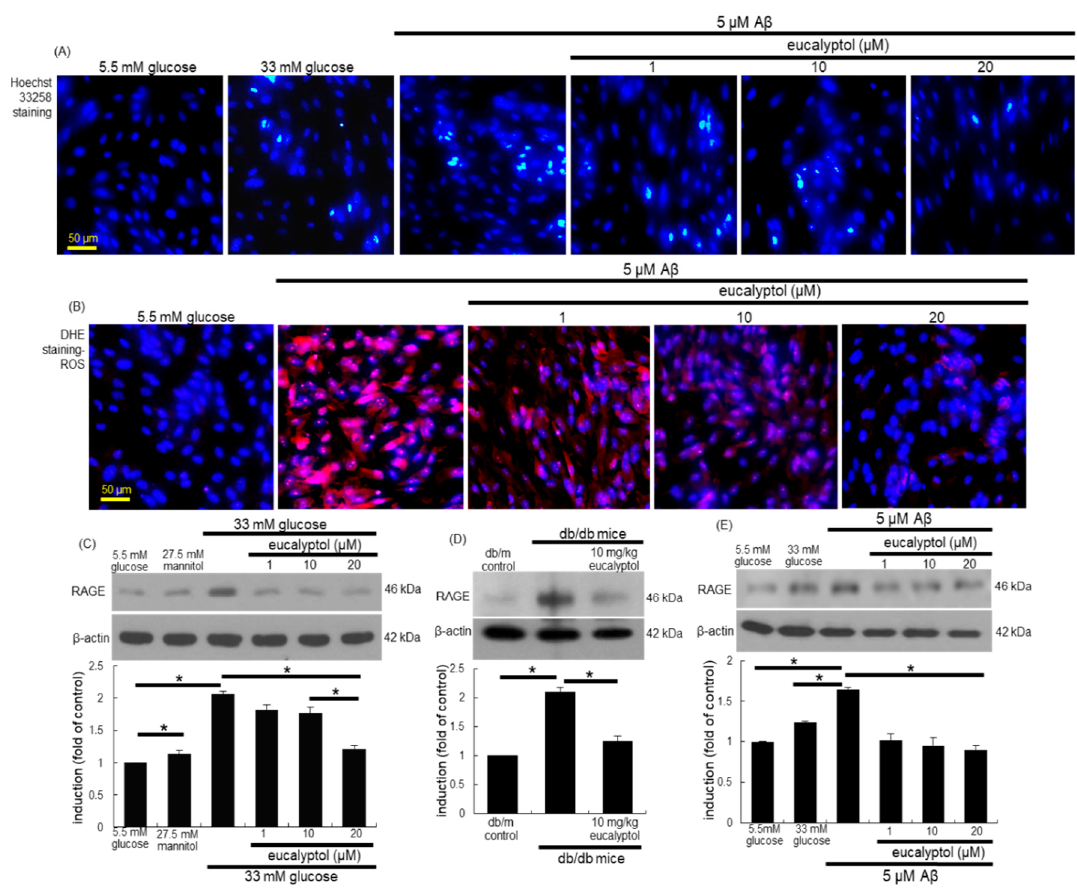
Figure 9. Blockade of A β -induced nuclear condensation ( A ), cellular ROS production ( B ) and cellular RAGE induction ( C – E ) by eucalyptol in human retinal pigment epithelial (RPE) cells. Hoechst 33258 staining was done for the measurement of nuclear condensation of RPE cells exposed to 5 µ M A β ( A ). For the measurement of ROS production ( B ), DHE staining was conducted in eucalyptol-treated RPE cells. Nuclear staining was done with 4 ′ ,6-diamidino-2-phenylindole. Hoechst 33258- and DHE-stained RPE cells were visualized under fluorescent microscopy. Each microphotograph (mean ± SEM, n = 3) was obtained by using a microscope system. Scale bars: 50 μ m. RPE cell lysates were subject to western blot analysis with a primary antibody against RAGE, and with β -actin as an internal control ( C – E ). Bar graphs (mean ± SEM, n = 3) in the panel represent densitometric results of blot bands. * Values in respective bar graphs indicate a significant difference at p < 0.05.